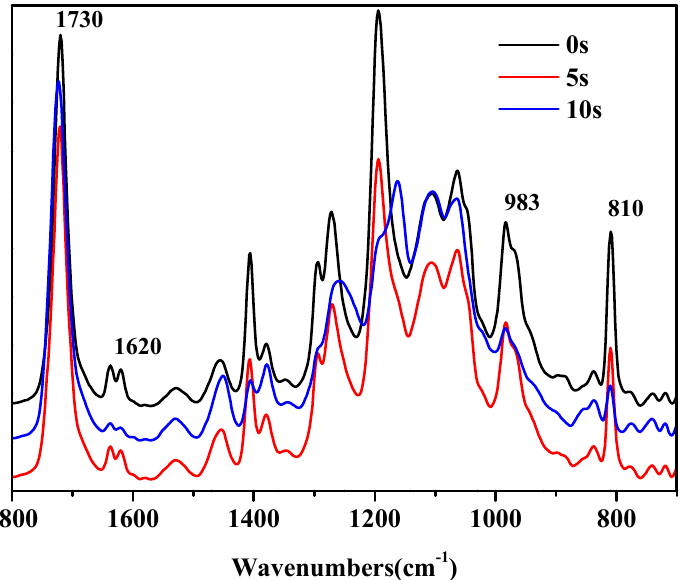
Figure 4. Infra-red spectrum of photosensitive resin under different irradiation times.